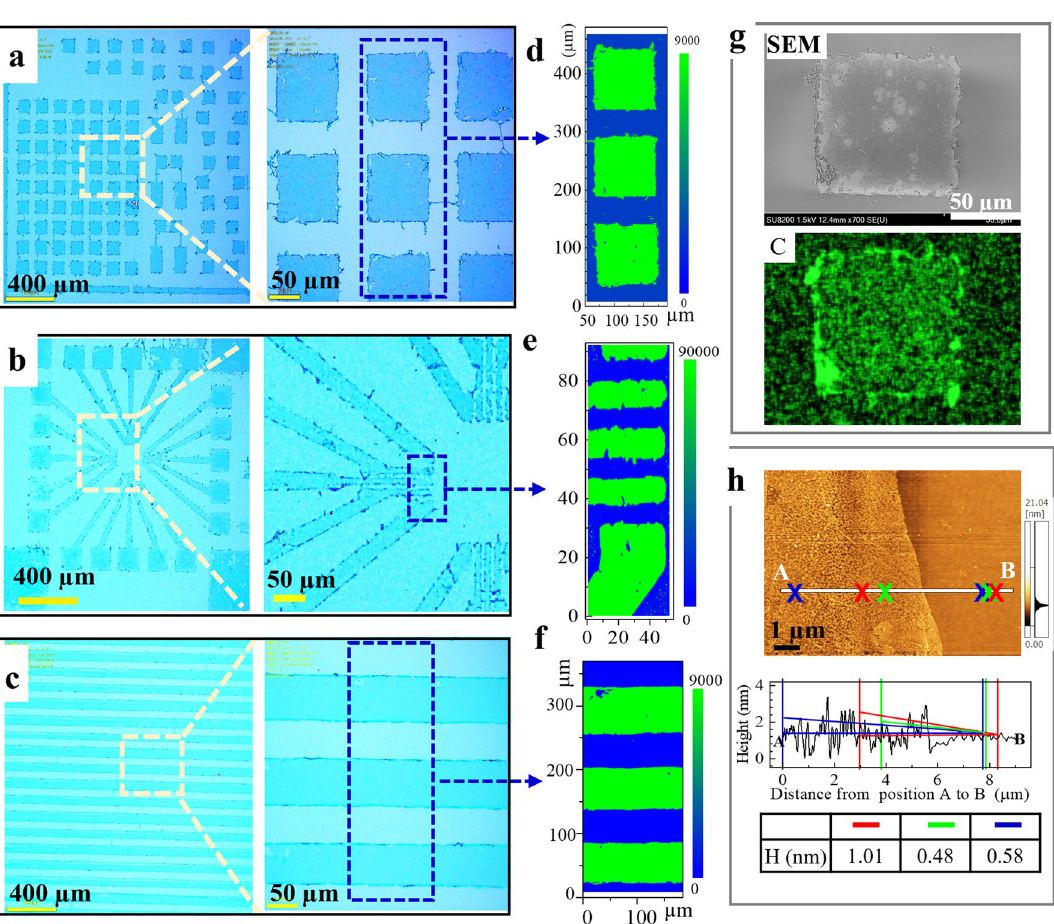
Figure 3. Three typical patterned graphene arrays. Optical microscopy images show close-up views of different areas of the different patterned graphene arrays on Si-wafers obtained by NaClO etching after gold cover removal ( a , d , and c ). Raman mapping of areas (marked as blue squares in a , b , and c ) is shown for 2D peak intensities at ~ 2683 cm -1 ( d , e , and f ). ( g ) SEM image from one of the patterned square areas in ( a ) alongside the elemental carbon (C) mapping image. ( h ) Atomic force microscopy (AFM) topographic image for one of the patterned graphene ribbon edges in image ( c ), and the corresponding height profiles for the line from position A to position B